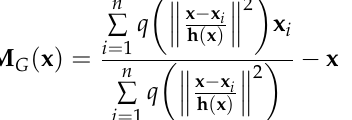
Algorithm 1. Mean Shift Segmentation